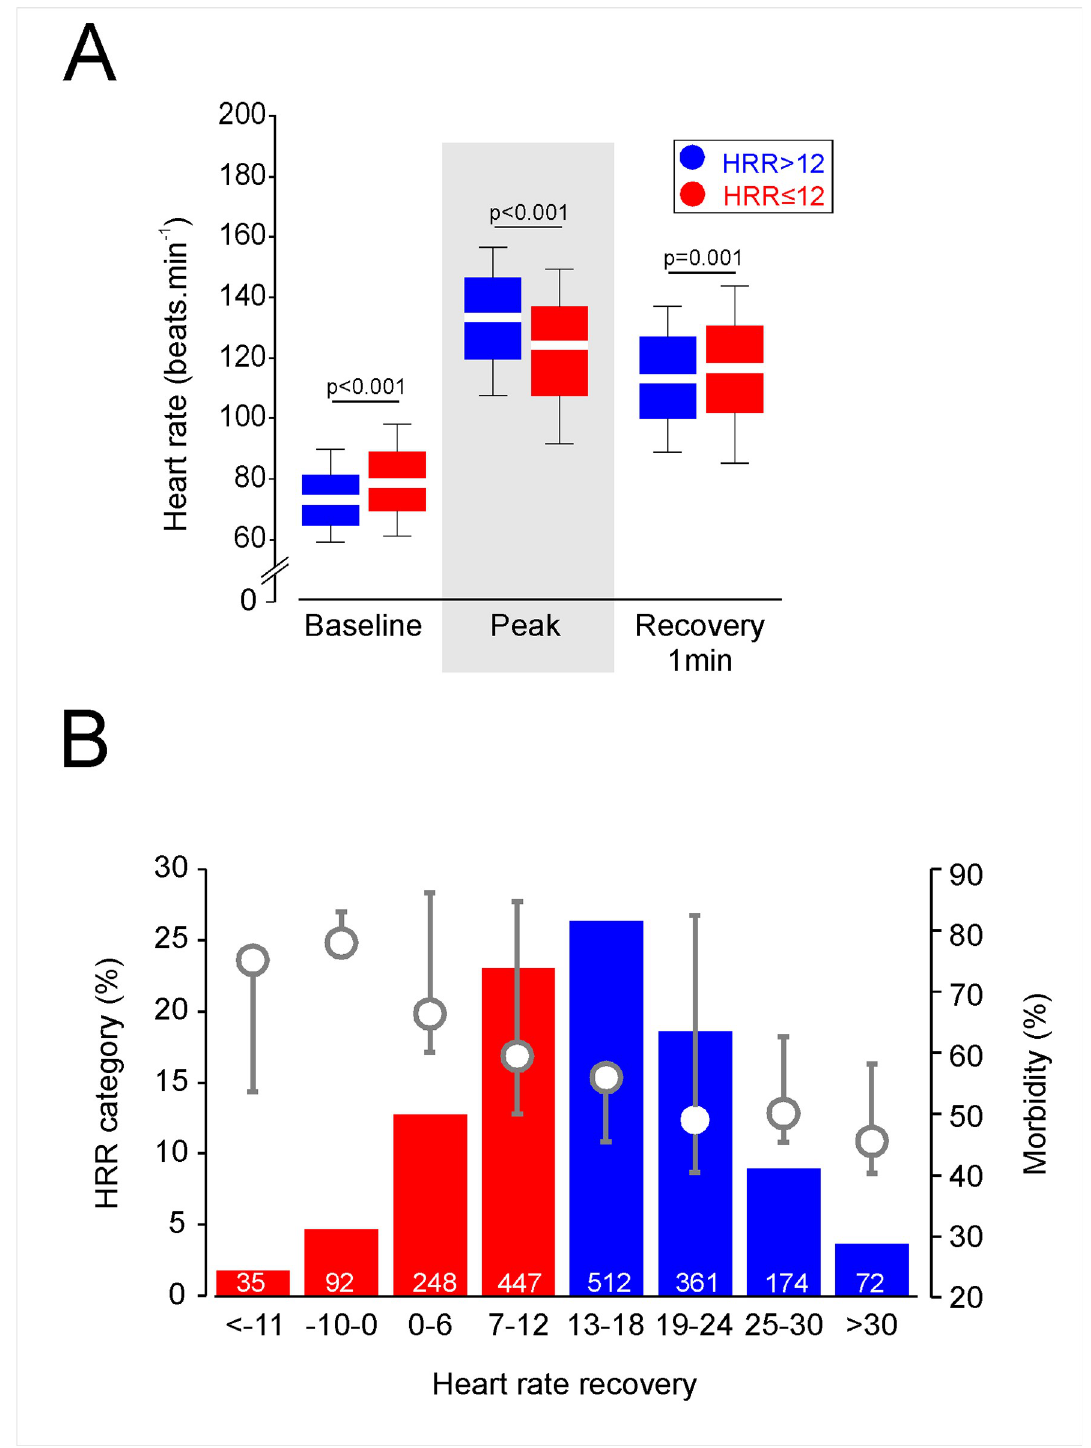
Fig 2. Exercise-evoked heart rate dynamics and distribution of heart rate recovery. A. Exercise-evoked changes in heart rate from baseline to peak, and 60s after recovery from the end of exercise in patients with delayed, or normal, heart rate recovery > 12beats.min -1 . Red colour indicate values below which are associated with increased risk of all-cause mortality obtained in large epidemiological studies.[13, 14] Median (25-75 th centile values shown; p values determined by ANCOVA, controlling for age. B. Distribution of heart